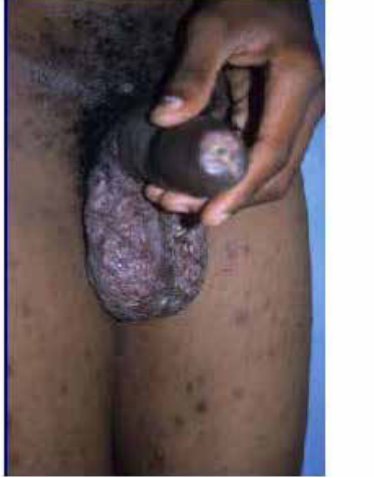
Figure 6. Overlap of primary and secondary syphilis in an HIV-infected patient